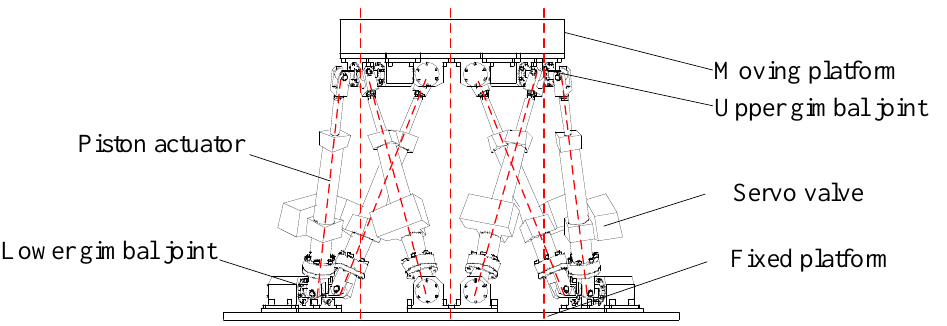
Figure 1. Schematic diagram of a Stewart manipulator.